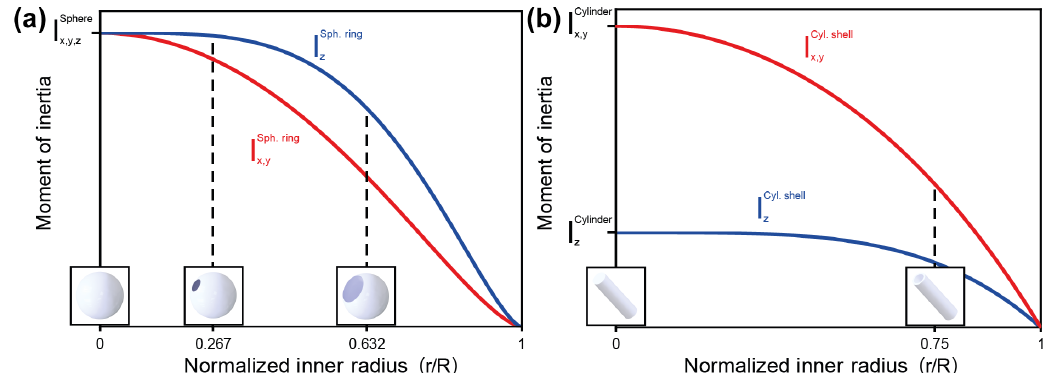
Figure 4. Moments of inertia for spherical and cylindrical rotors as a function of the normalized inner radius r/R . (a) I z (blue) and I x,y (red) for a spherical rotor as a function of the normalized inner radius. The rotors spun in this study correspond to r/R = 0 . 267. The difference between I z and I x,y is maximized at r/R = 0 . 632. (b) I z (blue) and I x,y (red) for a cylindrical rotor with aspect ratio k = 4 as a function of the normalized inner